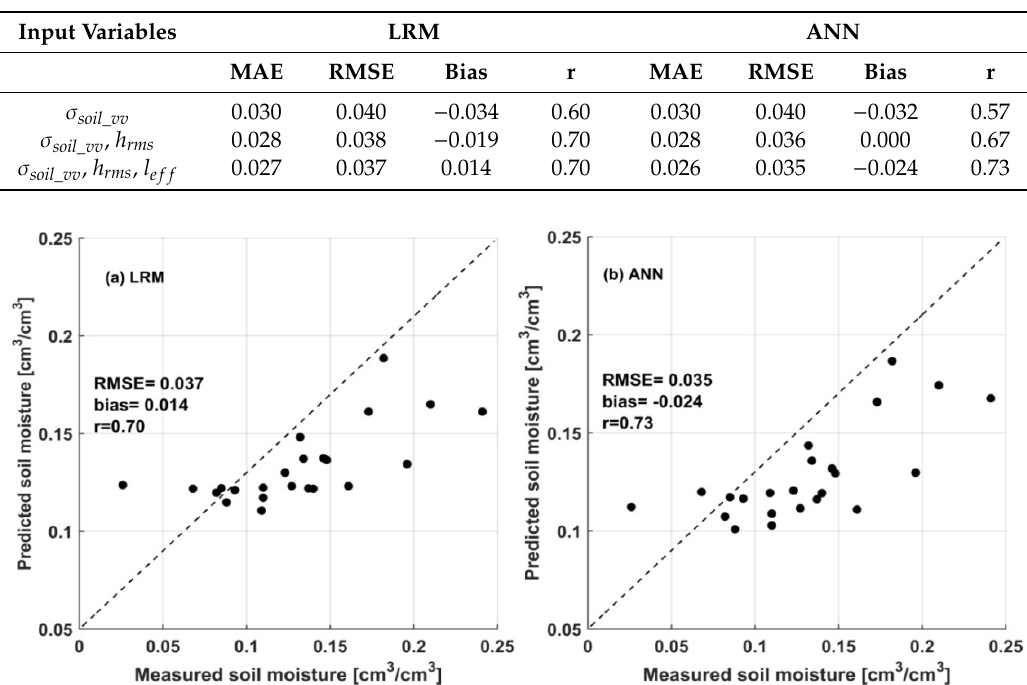
Figure 9.Scatter plots showing the comparison between measured and predicted soil moisture based on the prediction model developed using 𝜎 (cid:3046)(cid:3042)(cid:3036)(cid:3039)_(cid:3049)(cid:3049) , ℎ (cid:3045)(cid:3040)(cid:3046) , and 𝑙 (cid:3032)(cid:3033)(cid:3033) input variables for ( a ) LRM and ( b )